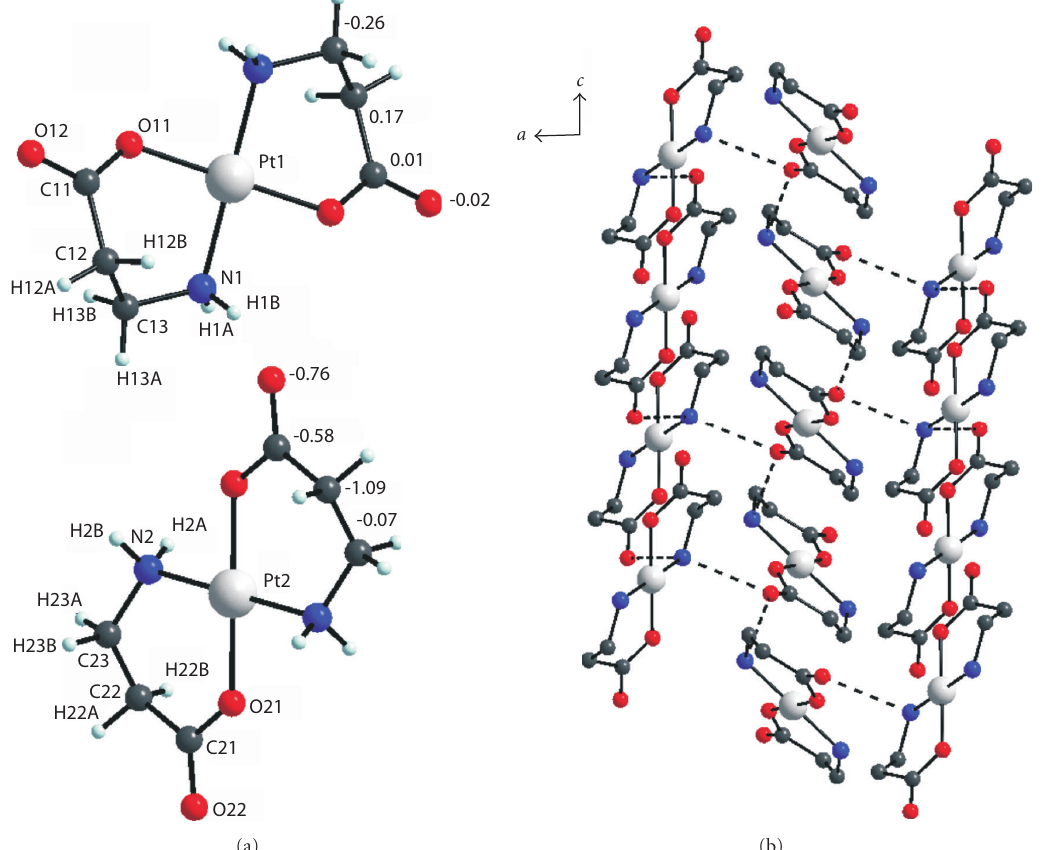
Figure 3: Molecular structure of Pt1 and Pt2 in trans -[Pt( β -Ala) 2 ] (a); structure projected on the (001) plane (b).